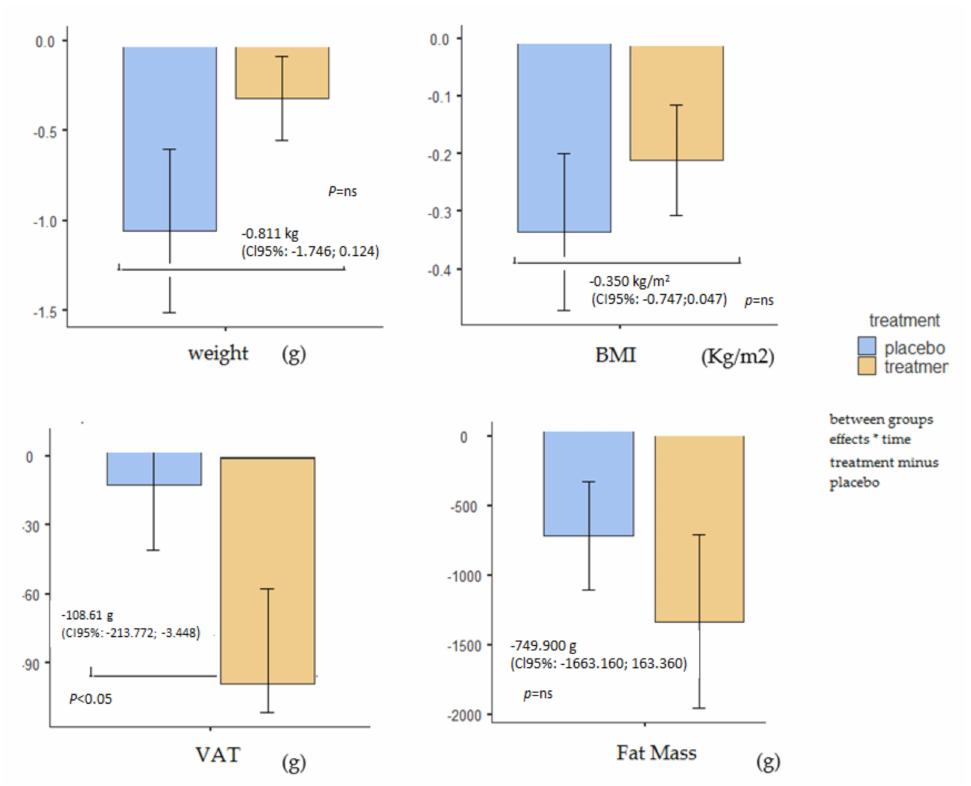
Figure 2. Pre-post body composition measurements in placebo and intervention groups (within and between effects). *: effects for